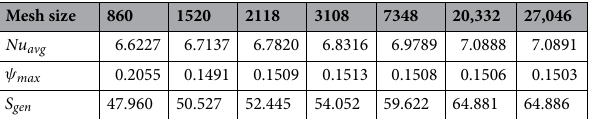
Table 2. Evaluation of the Nu avg , ψ max and S gen for diverse grid resolution.